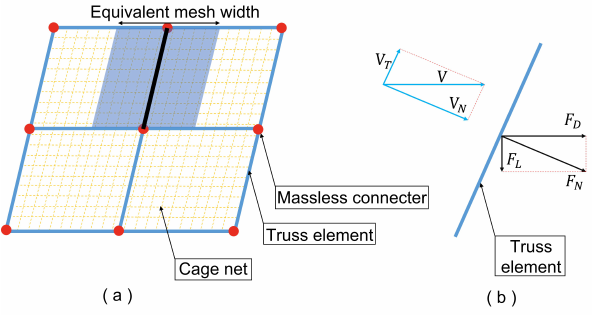
Figure 3: The numerical model of netting: (a) The structural representation of a net panel as a group of equivalent truss elements. The truss element in black represents the actual net twines in the vertical direction within an equivalent mesh width; (b) The fluid load acting on a truss element.